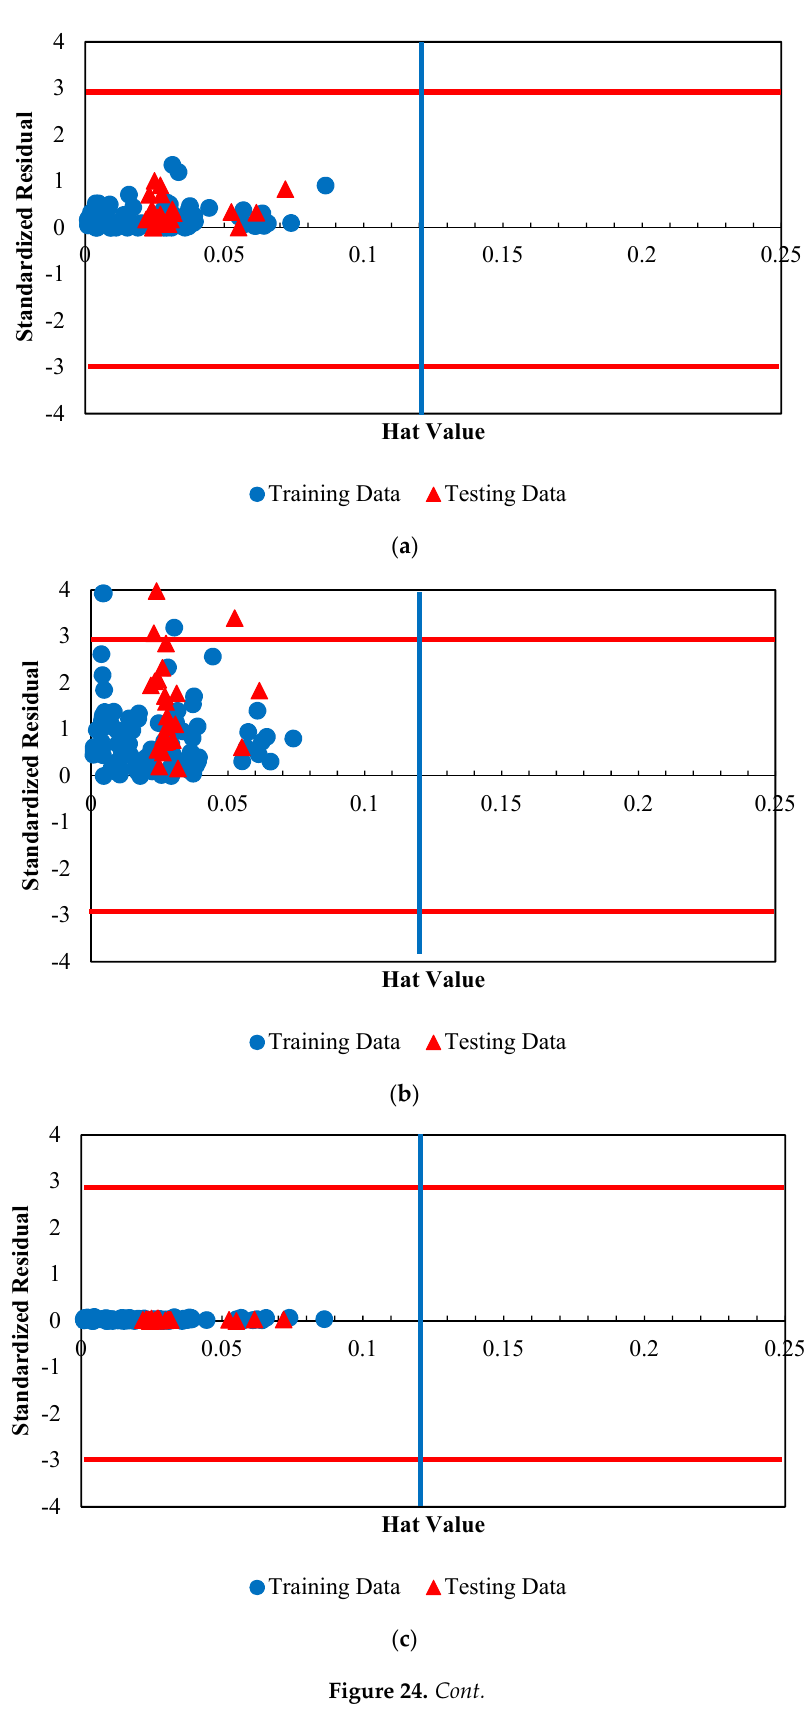
Figure 23. Comparison between PSO ‐ ANN outputs and experimental thermal conductivity of (cid:1832)(cid:1857) (cid:2870) (cid:1841) (cid:2871) /ethylene glycol ‐ water nanofluid, versus volume fraction (%) at different condition.